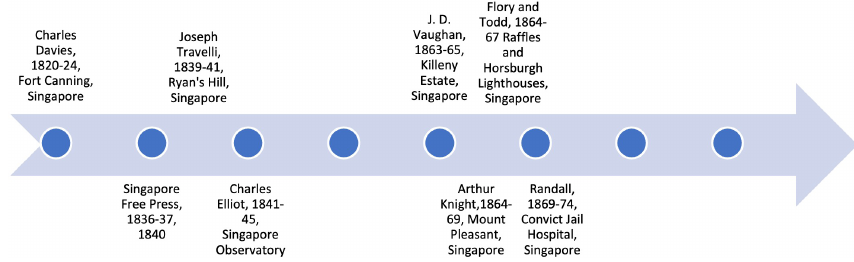
Figure 2. Summary timeline of observations for Singapore,